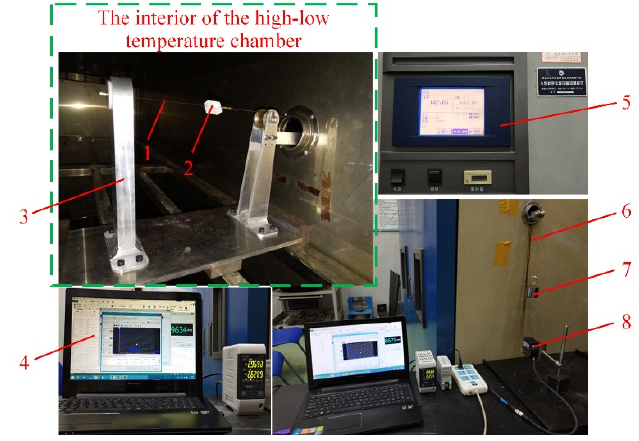
Figure 4. The thermal cycling experiments.